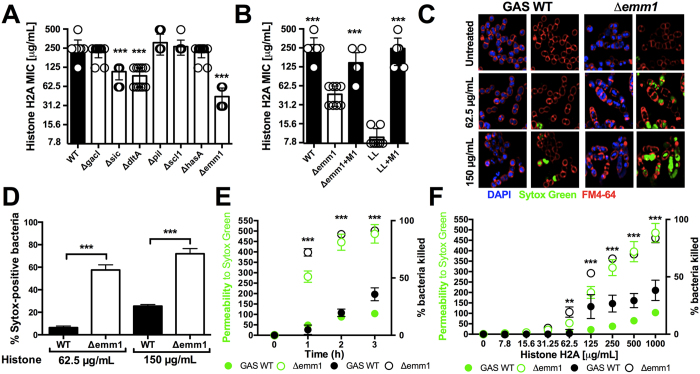
GAS M1 protein protects against histones.(A) Screening of virulence-associated genes with GAS M1 background of isogenic mutants Δsic, ΔdltA, ΔgacI, ΔhasA, Δscl1, Δpil and Δemm1 mutants compared to GAS M1 WT. (B) Histone H2A MIC assays with GAS WT, Δemm1 mutant and complemented mutant (Δemm1+pM1) as well as LL and heterologous expression of M1 protein in LL (LL+pM1) are shown. (C) Effect of histone treatment on GAS WT and Δemm1 mutant bacteria were visualized using the cell-impermeable DNA dye Sytox Green (green), the cell-permeable DNA dye DAPI (blue) and the membrane dye FM4-64 (red) by confocal microscopy after 3 h of incubation in the presence or absence of histone at 62.5 μg/mL or 150 μg/mL histone H2A and (D) the Sytox Green-positive population in random view fields was quantified. (E) Time-dependency of permeability was assessed using the cell-impermeable dye Sytox Green, which yielded into fluorescent signal upon interaction of dye with bacterial DNA, and was monitored with 1000 μg/mL histone for GAS WT and Δemm1 mutant and bacterial survival was simultaneously calculated via CFU enumeration relative to initial inoculum over a 3 h time course. (F) Bacterial permeability was investigated by treatment with increasing concentrations of histones ranging from 7.8 μg/mL to 1000 μg/mL histones and simultaneous CFU enumeration of bacterial survival relative to initial inoculum after 3 h incubation. Results shown represent average ± SEM values and were analyzed by Student’s t-test in (D–H) or Mann-Whitney test in (A,B) (**P < 0.01, ***P < 0.001). Each dot represents one sample. All experiments have been carried out a minimum of three times run in triplicates, except for (C) which was repeated three times in monoplicates.